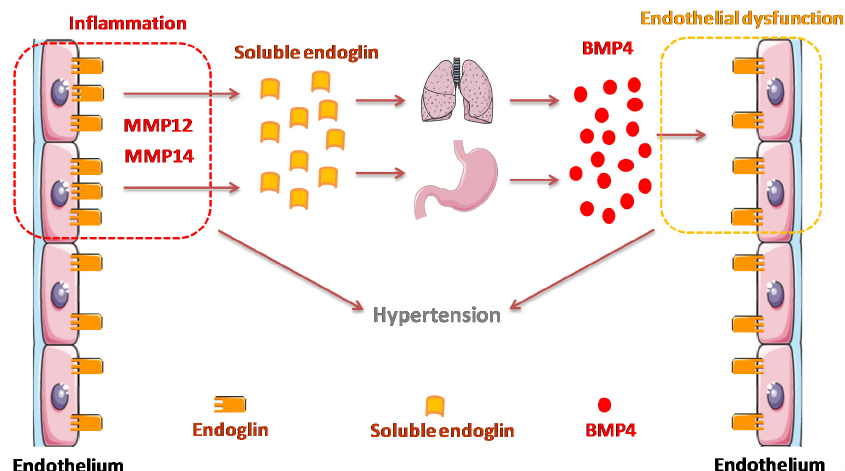
Figure 7. Hypothetical model for BMP4 in sEng-dependent effect in hypertension. Upon inflammation, MMP12 and/or MMP14 trigger the release of sEng in endothelial cells by proteolytically cleaving membrane-bound endoglin. In turn, sEng stimulates the expression of BMP4 in different organs, including lung, stomach and duodenum. Next, circulating BMP4 contributes to endothelial dysfunction, leading to hypertension.